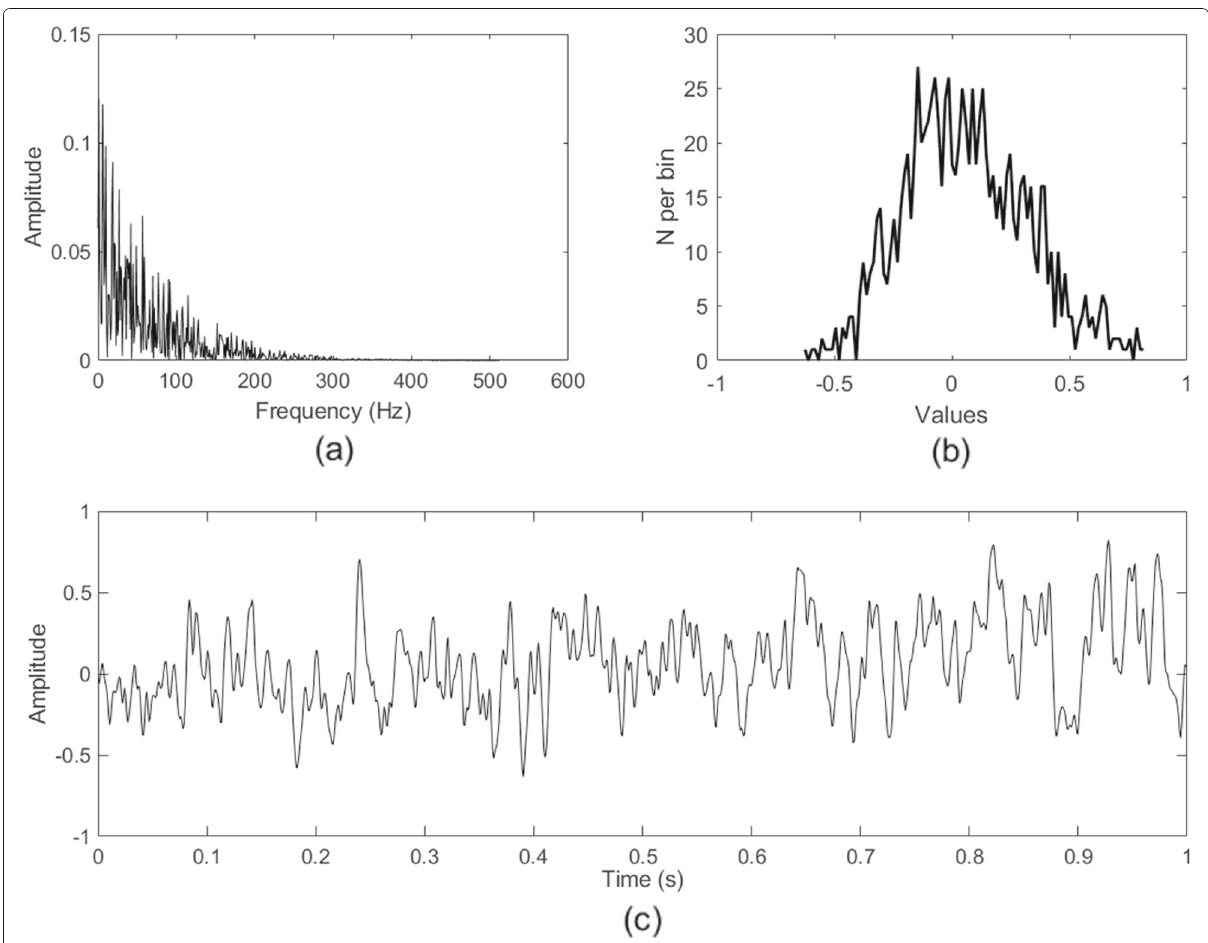
Fig. 3 a Frequency domain representation of 1/f noise. b Histogram of noise. c Time domain representation of noise at dipole 2004